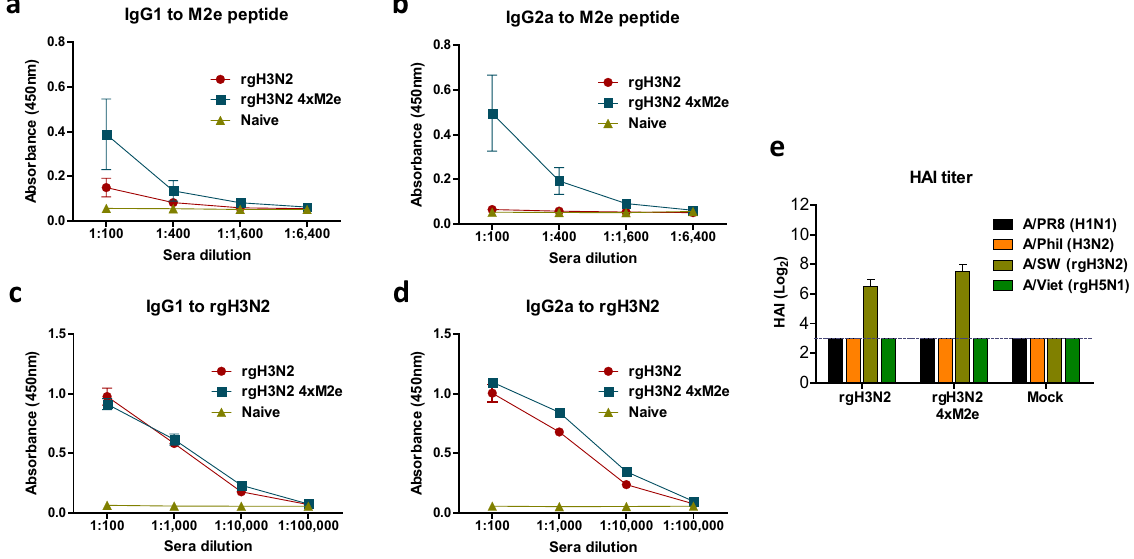
Figure 2. Intranasal prime inoculation of live rgH3N2 4xM2e virus induces M2e specific serum IgG isotype antibody responses. ( a ) M2e specific IgG1 antibodies. ( b ) M2e specific IgG2a antibodies. ( c , d ) Virus rgH3N2 specific IgG1 and IgG2a antibodies. Serum samples were collected at 2 weeks after prime dose intranasal inoculation of mice (n = 15 /group). ( e ) Serum HAI titers against the viruses (A/PR8, A/Phil, rgH3N2 and A/Viet) were determined 14 days after immunization. rgH3N2: 6:2 reassortant with WT HA and NA of A/ Switzerland/2013. rgH3N2 4xM2e: 6:2 reassortant with 4XM2e-HA and NA of A/Switzerland/2013. Each individual mouse animal is analyzed. Error bars indicate mean ± displayed high antigenic reactivity to mouse antisera of rgH3N2 infection and goat antisera of A/Indiana/2011 (H3N2) immunization (Supplementary Fig. S1). These results support that 6:2 reassortant rgH3N2 4xM2e virus displays high reactivity to M2e specific 14C2 mAb and retains similar antigenicity to antisera of H3N2 viruses as compared to rgH3N2 virus. Reassortant rgH3N2 4xM2e virus is attenuated in mice but does not compromise replication capacity in egg substrates. We determined whether rgH3N2 4xM2e virus would retain the compara- ble replication capacity in egg substrates, compared to WT rgH3N2. Both chimeric rgH3N2 4xM2e and WT rgH3N2 viruses displayed similarly high levels of egg infectious titers (EID 50 /ml) and hemagglutination activity units (HAU) (Fig. 1c,d). Next, at designated time points after incubation of embryonated chicken eggs with 10 4 EID in egg substrates as WT rgH3N2 virus. The reassortant rgH3N2 4xM2e virus does not compromise replication capacity in egg substrates. Consistent, the overall trends in the growth patterns of rgH3N2 and rgH3N2 4xM2 reassortants in MDCK cells were similarly observed as those in the eggs despite some variations at different culture times and temperatures (Supplementary Fig. S2). As an indicator of pathogenicity, weight changes and activity were monitored in mice after intranasal inocu- lation with rgH3N2 4xM2e and rgH3N2 viruses. Both mouse groups infected with rgH3N2 (10 5 EID 50 ) and rgH3N2 4xM2e (10 5 and 10 6 EID 50 ) did not show body weight loss (Fig. 1f) while the mice with A/PR8 even at a 100-fold lower dose (10 4 EID 50 ) consistently displayed severe weight loss and died of infection. Consistent, mice inoculated with WT A/PR8 virus showed highest levels of replicating viral titers in the lower respiratory tracts of lungs, which is at approximately 100 folds higher than those in the upper respiratory nasal turbinates at day 3 post inoculation (10 4 EID 50 ) (Fig. 1g). In contrast, rgH3N2 (10 6 EID 50 ) and rgH3N2 4xM2e (10 6 EID 50 ) viruses showed approximately 10 5 magnitudes lower lung viral titers than WT A/PR8 virus (Fig. 1g). Instead, 100 folds higher viral replications were observed in the nasal turbinates than those in the lungs after inoculation of mice with rgH3N2 and rgH3N2 4xM2e virus (Fig. 1g). Consistent with the differences in viral titers between in the upper (nasal) and lower (lung) respiratory tracts, virus growths of reassortants at 33 °C MDCK cell cultures were 1 to 2 log10 magnitudes higher than those at 37 °C MDCK cell cultures (Supplementary Fig. S2). These results sug- gest that reassortant rgH3N2 and chimeric rgH3N2 4xM2e viruses are highly attenuated in mice with restricted replication in the upper respiratory tracts but retains replication capacity in egg or MDCK cell substrates. Prime dose of live rgH3N2 4xM2e virus induces M2e specific IgG isotype antibody responses. Intranasal prime inoculation of mice with live rgH3N2 4xM2e virus (10 5 EID 50 ) induced M2e specific IgG1 and IgG2a antibody responses at significantly higher levels than rgH3N2 (Fig. 2a,b). IgG antibod- ies specific for human M2e were induced at higher levels in prime sera from rgH3N2 4xM2e vaccination than those specific for avian M2e or swine M2e (Supplementary Fig. S3a), suggesting possible contribution of the